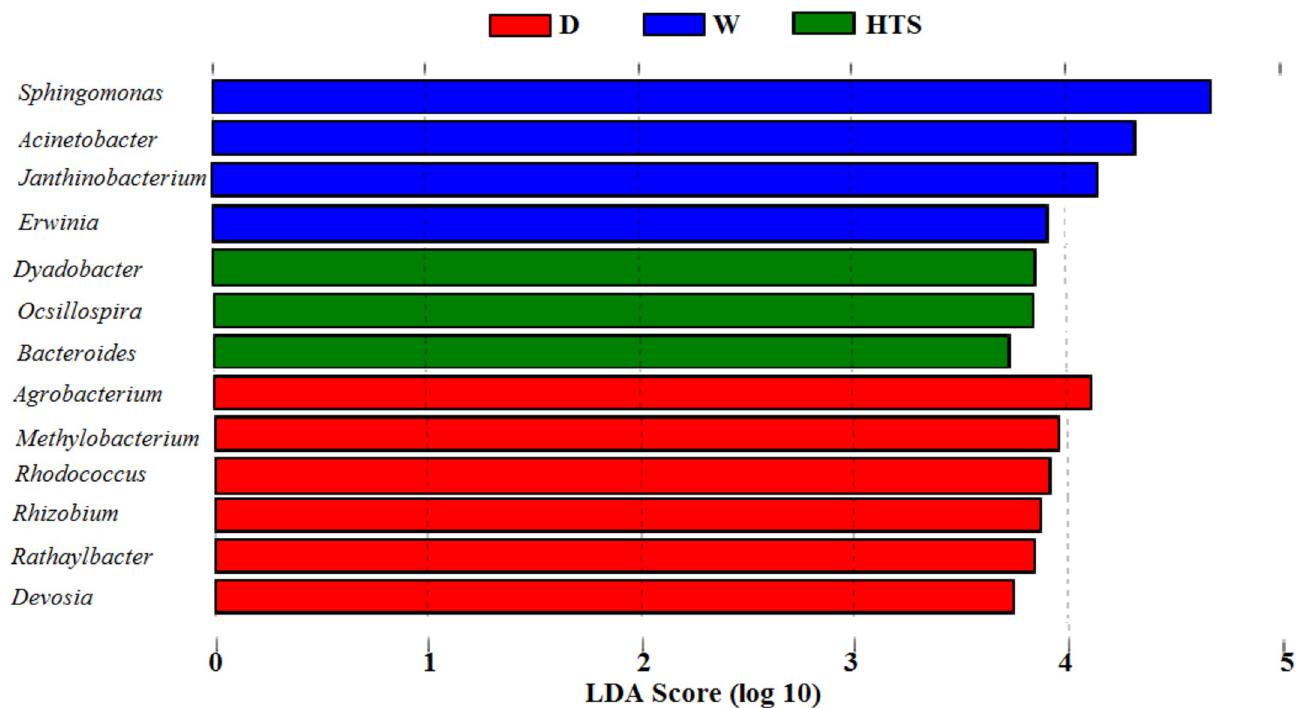
Fig 6. OTUs of viable bacteria differing between regimens at genera dry (D n = 10), HTS (n = 9) and soaked (W n = 11).